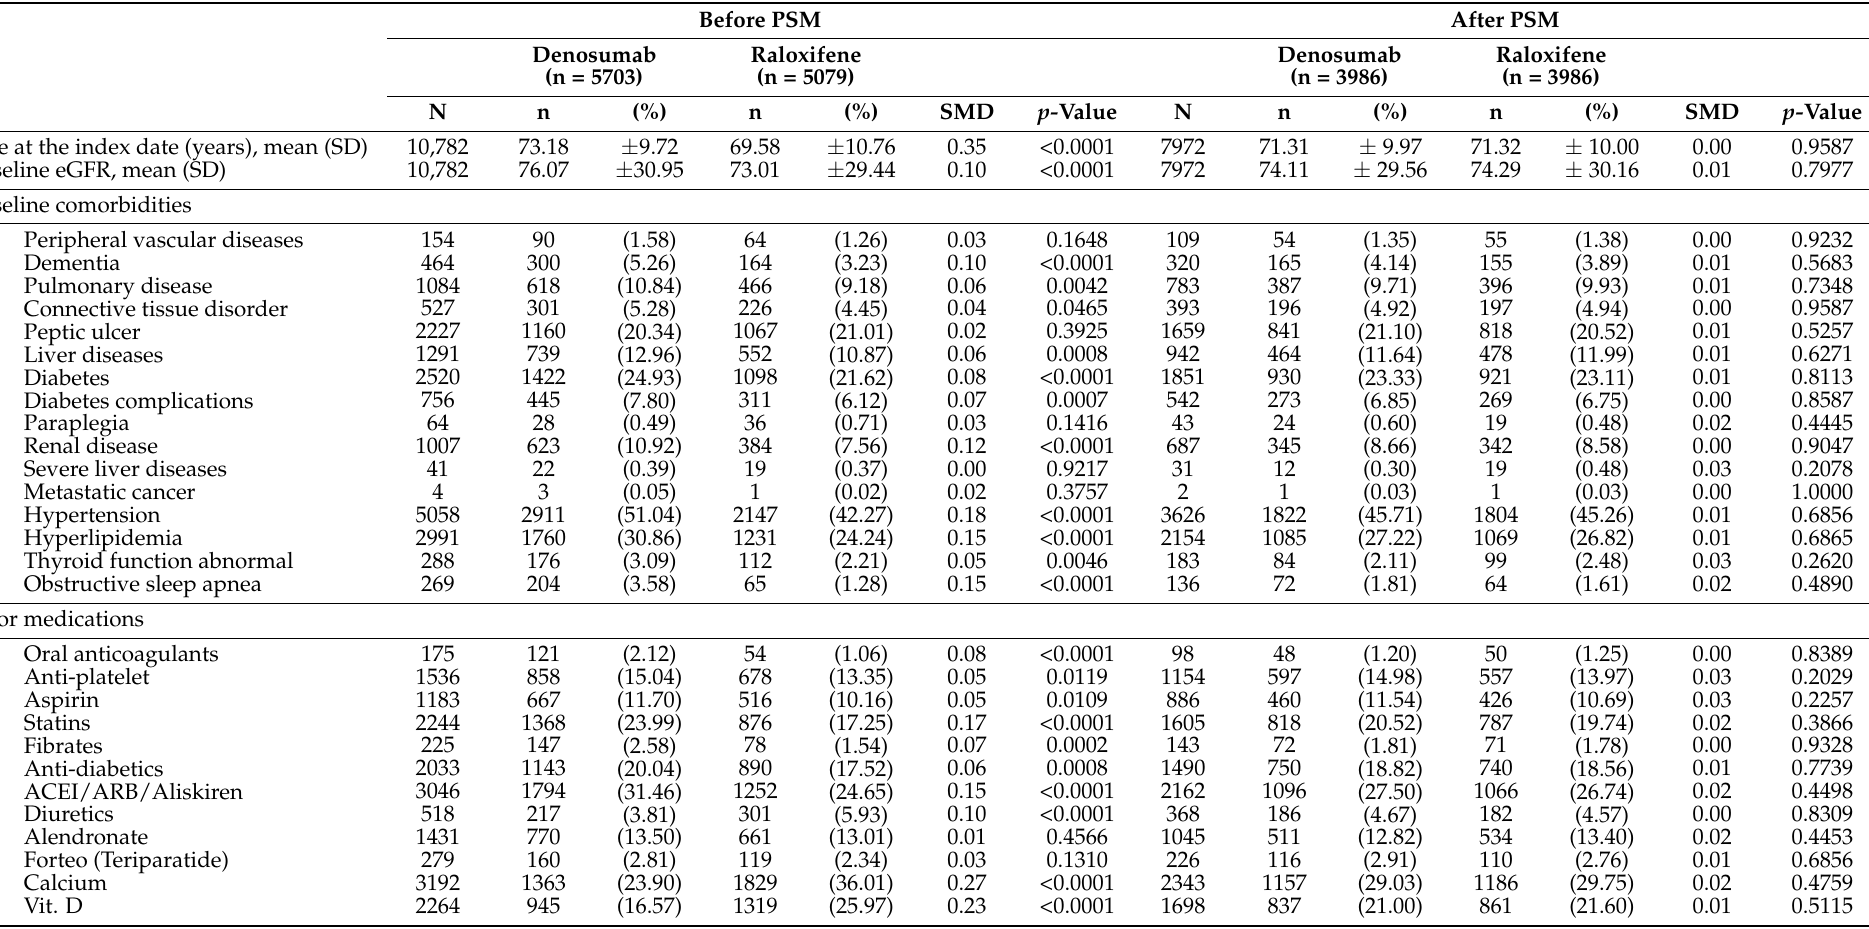
Table 1. Characteristics of the study cohorts before and after